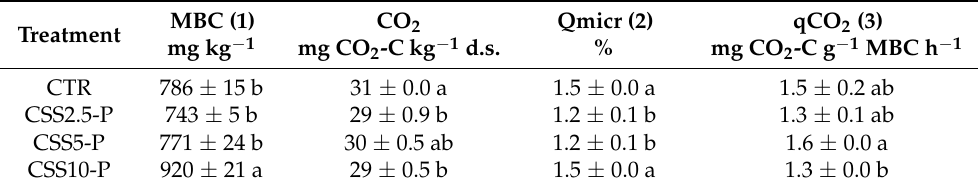
Table 4. Biochemical properties of soils amended with different concentrations of CSS (2.5 t ha − 1 , 5 t ha − 1 , 10 t ha − 1 ).